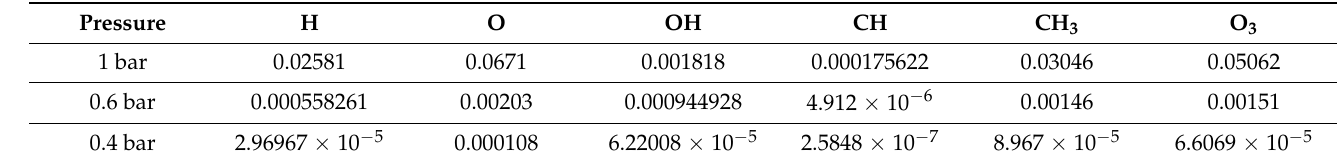
Table 3. Production of active radicals during the pulse